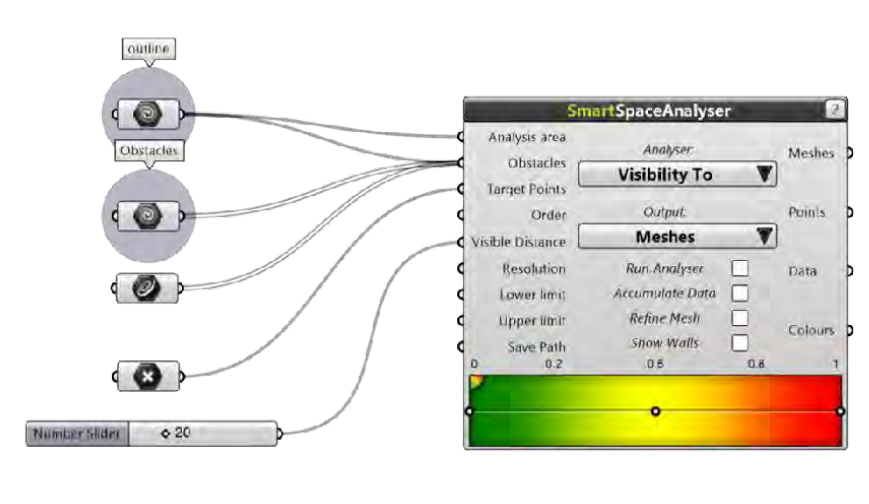
Figure 4. Visibility to Component (Smart space analyzer)